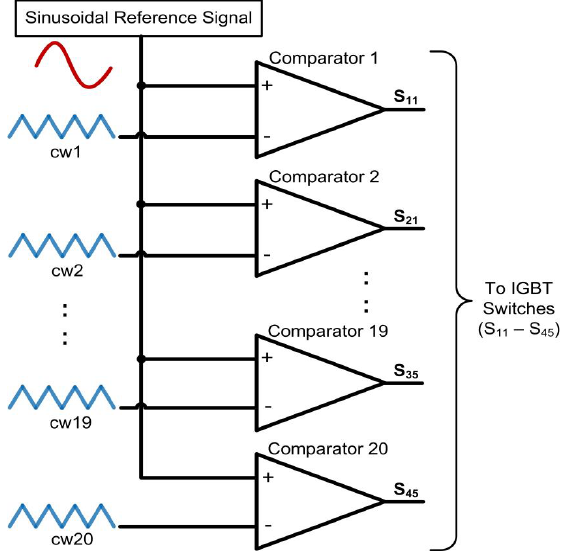
Figure 4. Switching generation using PD-SPWM technique for one-phase, 21-level multilevel